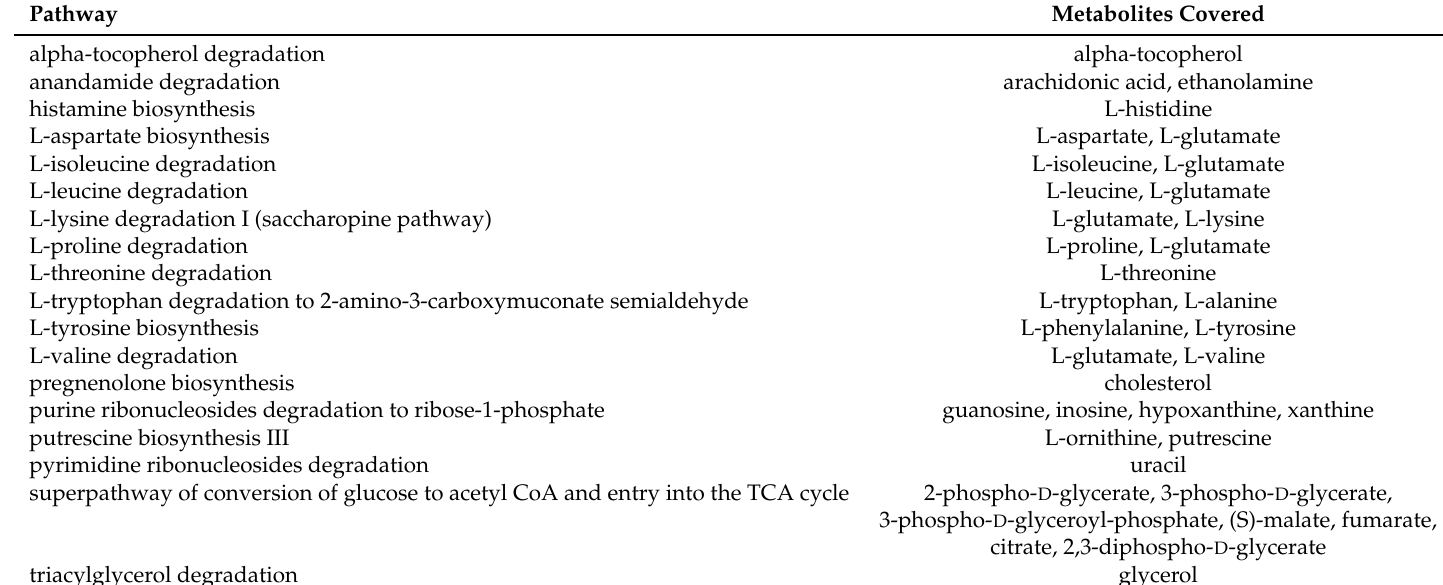
Table A4. ST000061, Pathway Covering Using Covered Compound Sparseness Cost